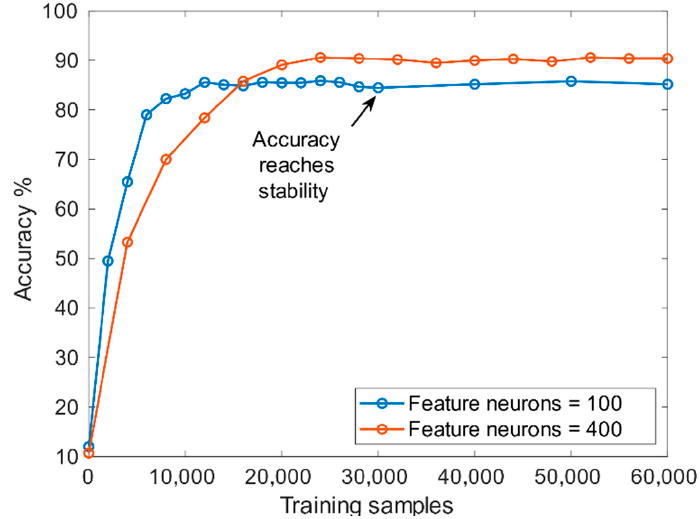
Figure 8. Relationship between accuracy and the number of training samples when the number of feature neurons is 100 and 400.